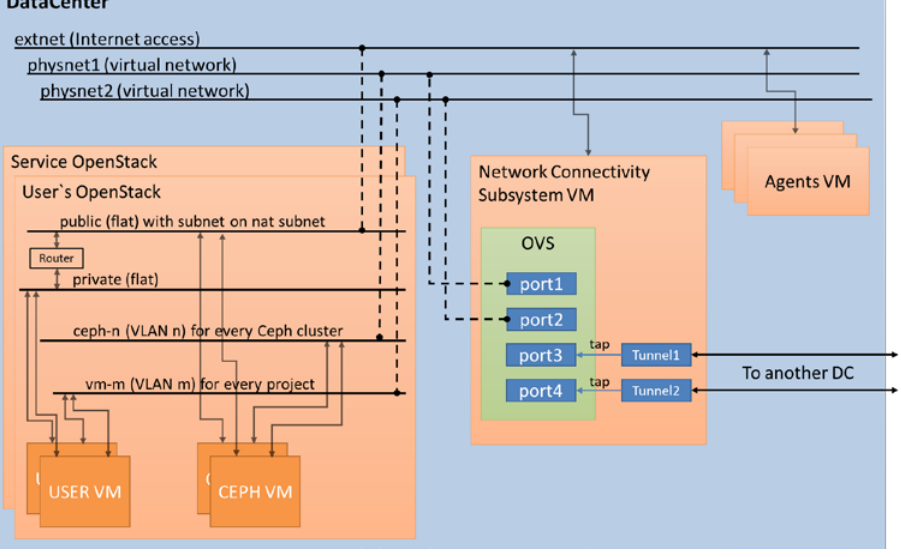
Fig. 3. User storage cluster creation sequence diagram